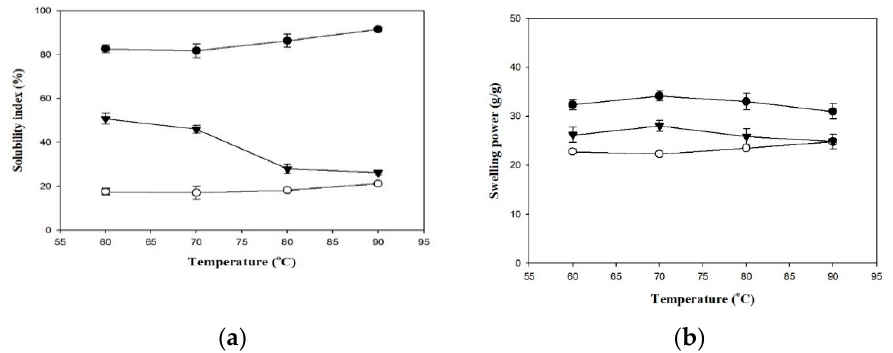
Figure 2. The solubility index ( a ) and swelling power ( b ) of formula thickeners at different temper- atures. Tapioca starch ( ● ); hydroxypropyl distarch phosphate ( ○ ); xanthan gum ( ▼ ). Error bars represent standard deviations. The uppercase letters are significantly different ( p < 0.05) at the same temperature. The lowercase letters are significantly different as a function of temperature for the same thickener ( p < 0.05).